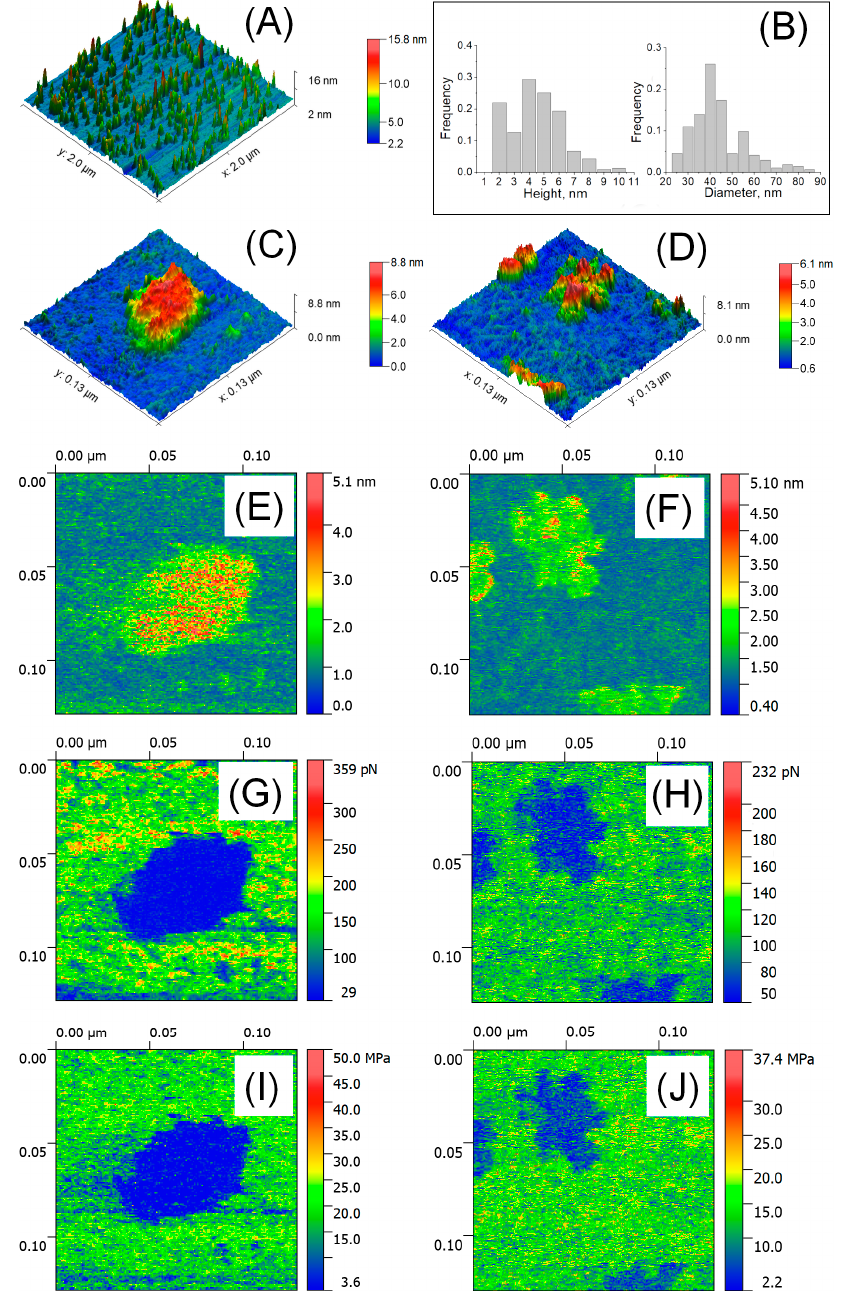
1 Figure 2. AFM detection of EVs in liquid. Large scale AFM image 2 × 2 µ m 2 ( A ) and size distribution ( n = 207–254) ( B ); HR AFM image 129 × 129 nm 2 of a single exosome ( C ), single exomeres and aggregates ( D ); deformation parameters ( E , F ), adhesion forces ( G , H ), and Young’s modulus ( I , J